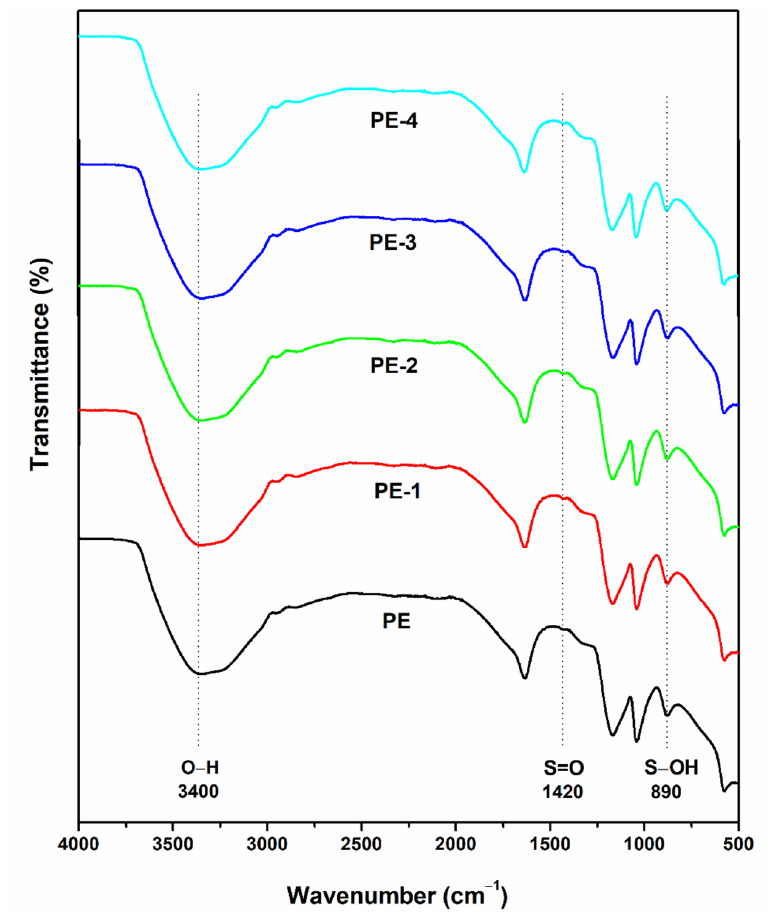
Figure 1. FTIR spectra of plane PVA (PE), PVA − 20 wt% TEOS (PE − 1), PVA − 40 wt% TEOS (PE − 2), PVA − 60 wt% TEOS (PE − 3) and PVA − 80 wt% TEOS (PE − 4) polymer gel electrolytes.